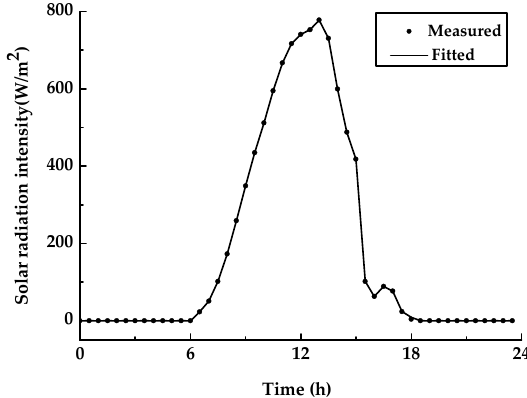
Figure 1. Measured and fitted air temperature on 24 August.